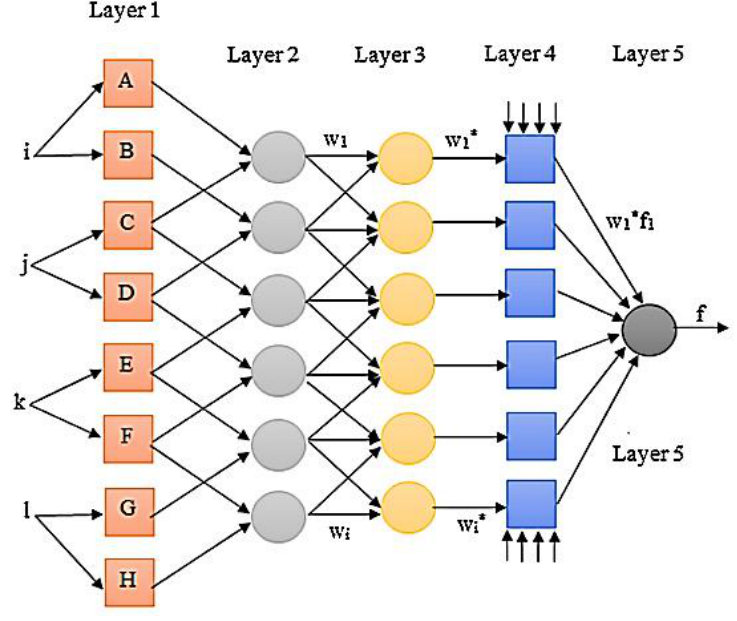
Figure 5. Adaptive neuro fuzzy system (ANFIS) model.